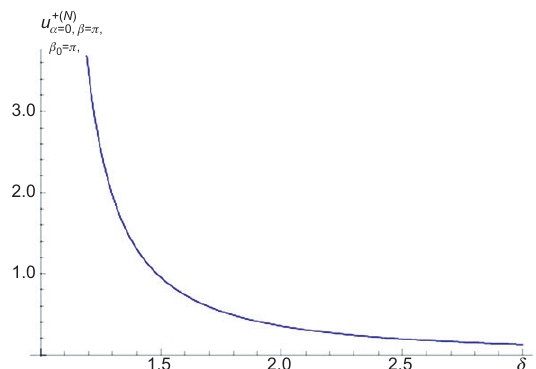
N u Figure 5 Normal surface displacement *( ) α = due to the hole as a 0 function of the aspect ratio δ = d/ ρ . The concentrated normal force is applied at the origin (see Figure 1), and the displacement is measured at the point of the force application. Here, d is a distance between the center of the hole and the straight surface and ρ is a radius of the hole. The displacement is represented in units